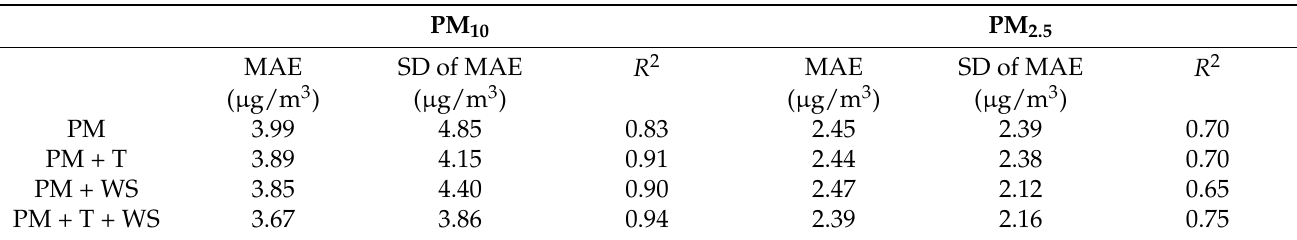
Table 5. MAE, SD of MAE and R 2 values that correspond to the FFNN methodology, for PM 10 and PM 2.5 and the four different input cases.